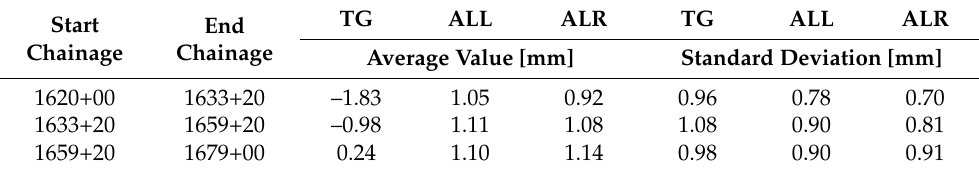
Table 5. Average and deviation of track parameters (section No. 4).